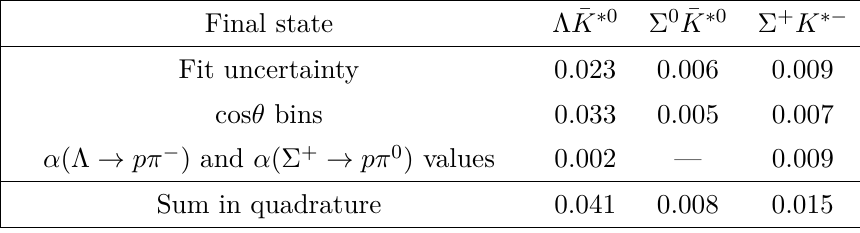
→ Λ ¯ K ∗ 0 ) , α (Ξ 0 → Σ 0 ¯ K ∗ 0 ) α (Σ 0 → γ Λ) , and c c